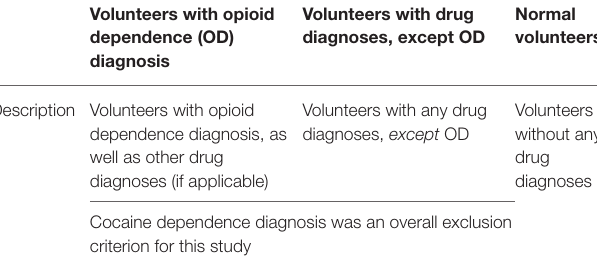
TABLE 1 | Description of diagnostic groups (DSM-IV